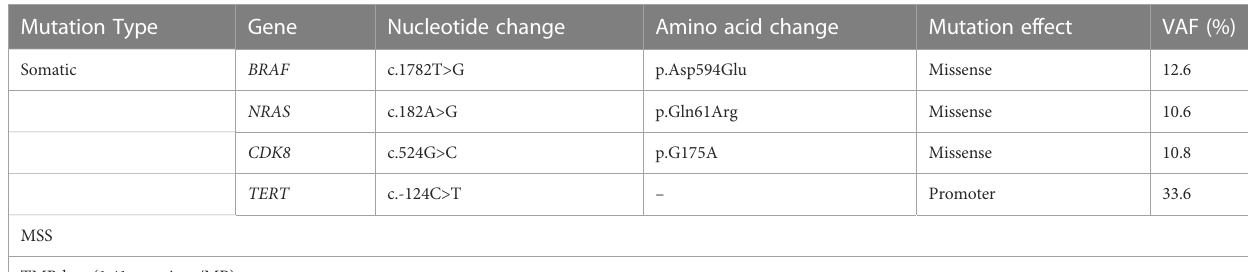
TABLE 1 Summary of NGS